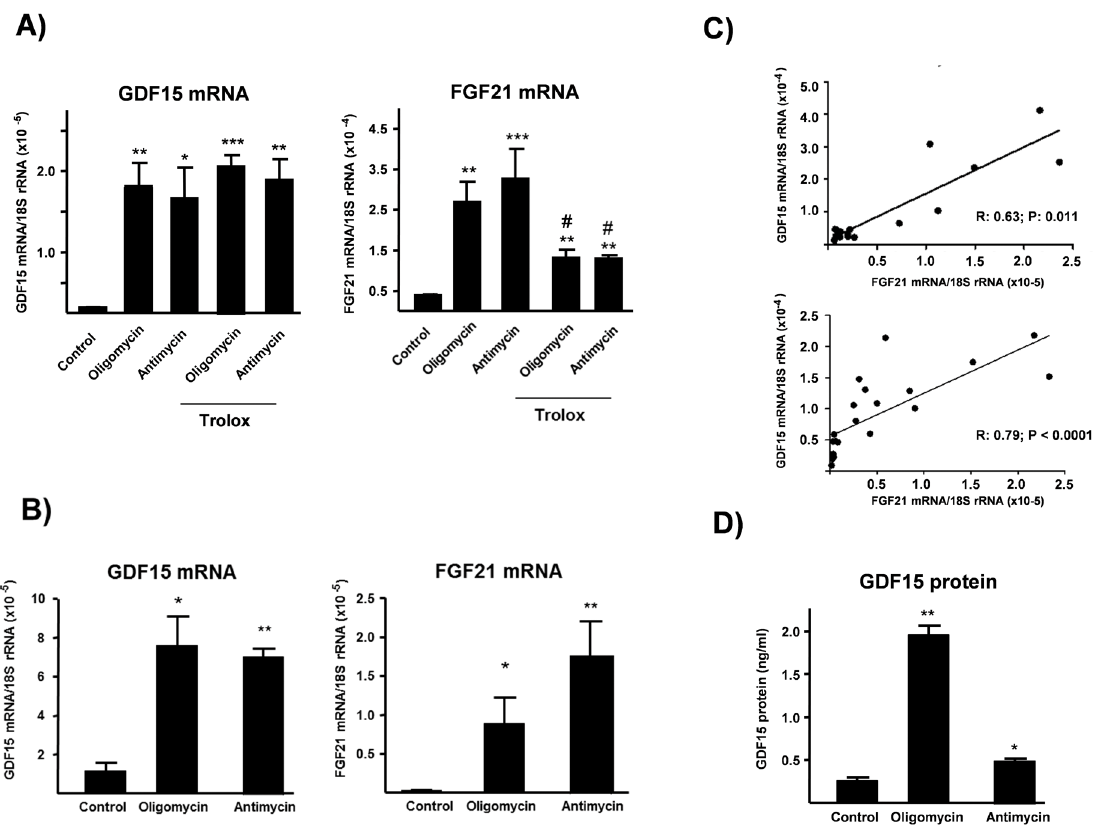
Fig 5. Effects of experimentally induced mitochondrial dysfunction on GDF-15 mRNA expression and GDF15 protein release in muscle cells. GDF15 mRNA and FGF21 mRNA levels in C2C12 myotubes (A) or LHCN myotubes (B), and correlation between GDF-15 mRNA levels and FGF21 mRNA levels (C) in the experimental settings in C2C12 cells (up) and LHCN cells (down). GDF-15 protein concentrations in C2C12 cell culture medium (D). Bars are means ± S.E.M. from 4 – 6 independent experiments. * p < 0.05, ** p < 0.01, *** p < 0.001, relative to untreated controls. # p < 0.05, relative to corresponding condition non-treated with Trolox. R and P values are shown in the correlation panel